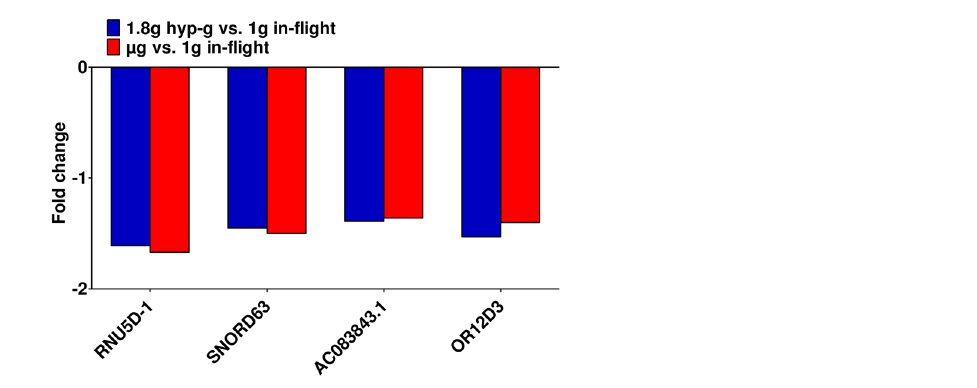
Figure 5. Gravity-responsive gene expression (parabolic flight). Expression level fold changes of genes in Jurkat T cells that are exclusively altered in both hypergravity (hyp-g) and microgravity ( µ g) when compared to 1 g in- flight controls during the 23 rd DLR parabolic flight campaign (log2 values, p < 0.05).